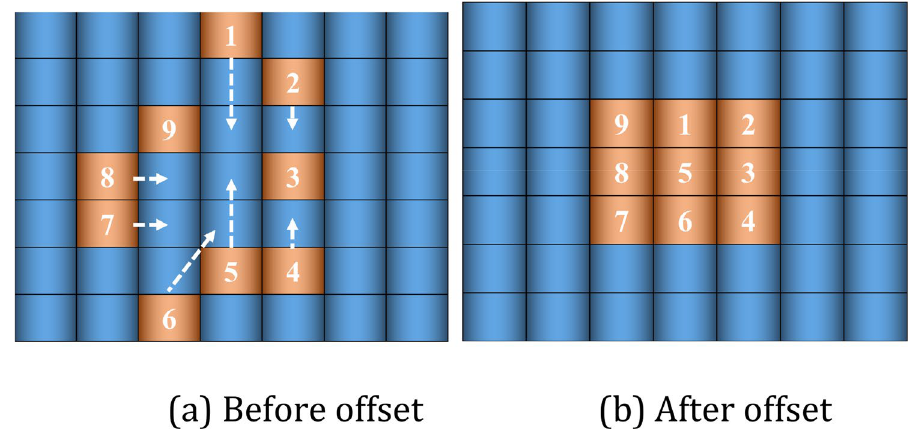
Figure 4. Feature map pixel offset in DFMRB.